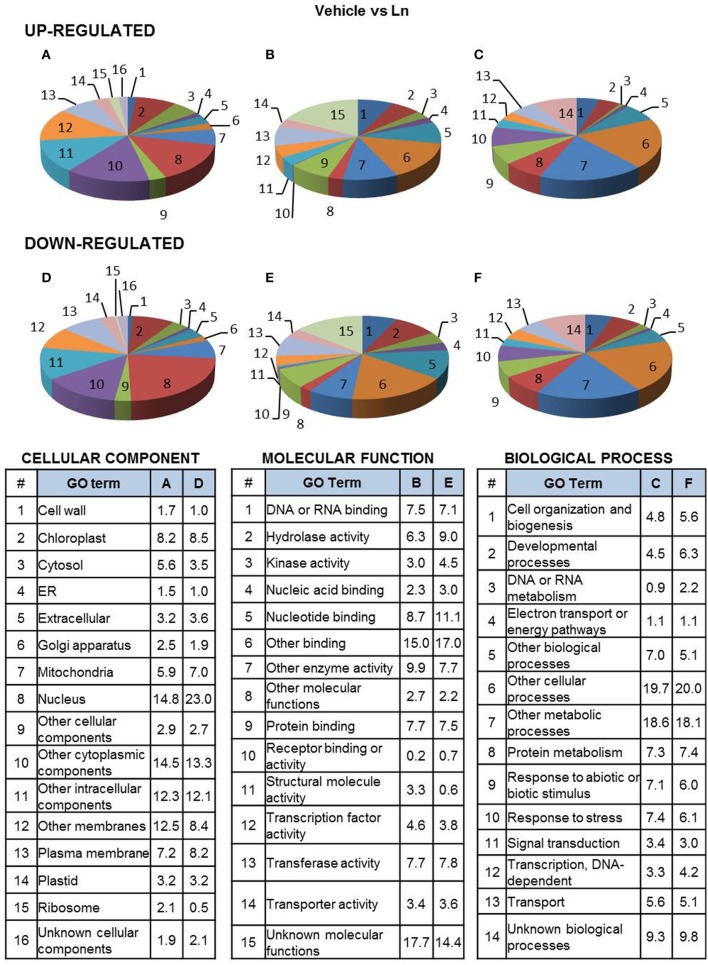
Functional classification of Ln-responsive genes in ACSC. Genes were classified by functional categories under the following gene ontology terms: cellular component (A,D), molecular function (B,E), biological process (C,F), up-regulated genes (A–C) and down-regulated genes (D–F). The number of genes assigned to each functional category is expressed as a percentage (%).